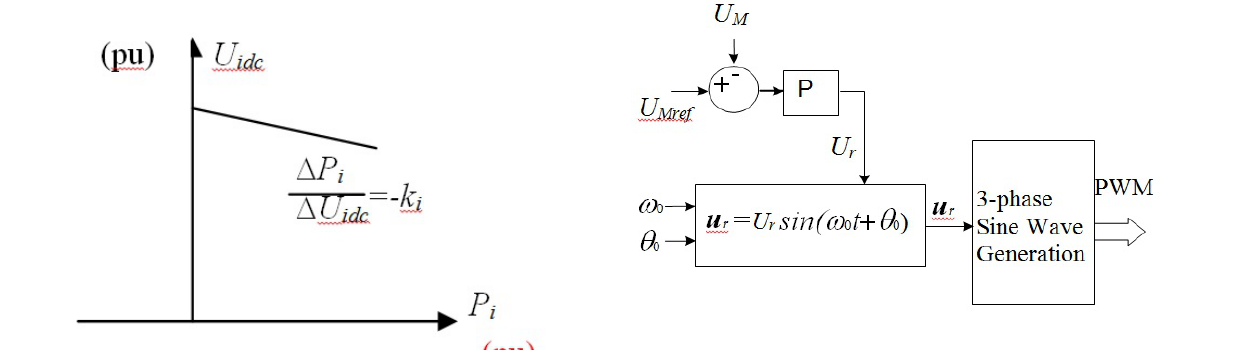
Figure 8. A 3-phase sine wave generation for ac voltage control